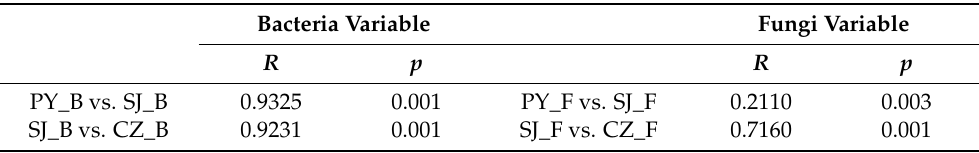
Figure 3. Difference of intestinal bacterial and fungal community composition among different lake groups by NMDS. Table 2. Difference of intestinal bacterial and fungal community composition among different lake groups based on ANOSIM.